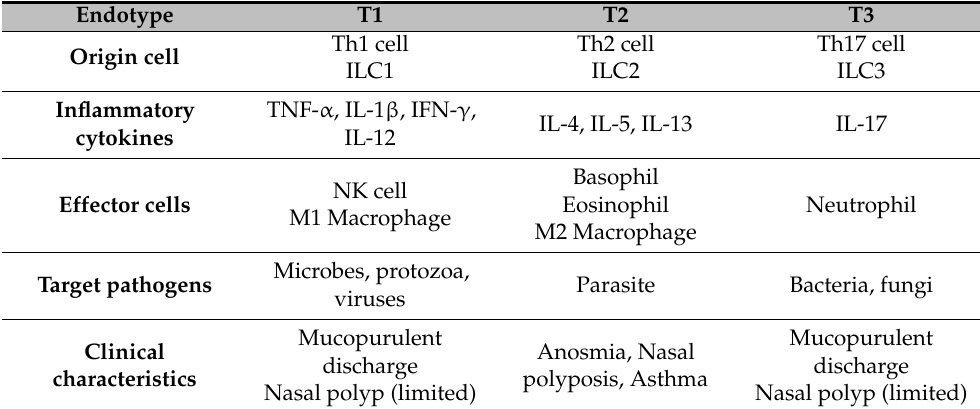
Table 1. Characteristics of inflammatory endotype in